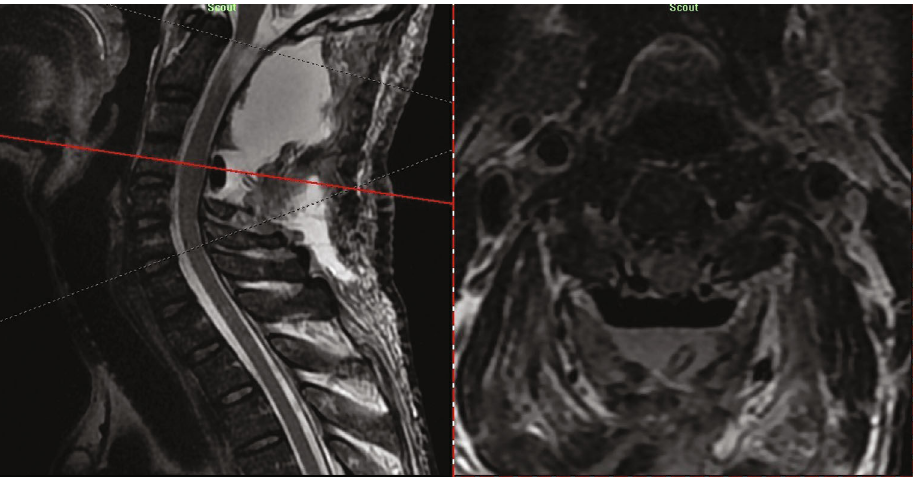
Figure 7: Sagittal-axial cross-view of postoperative T2WI of C4-C5 level showing spinal cord decompression and no remnant of bilateral intradural C4-C5 GNs.